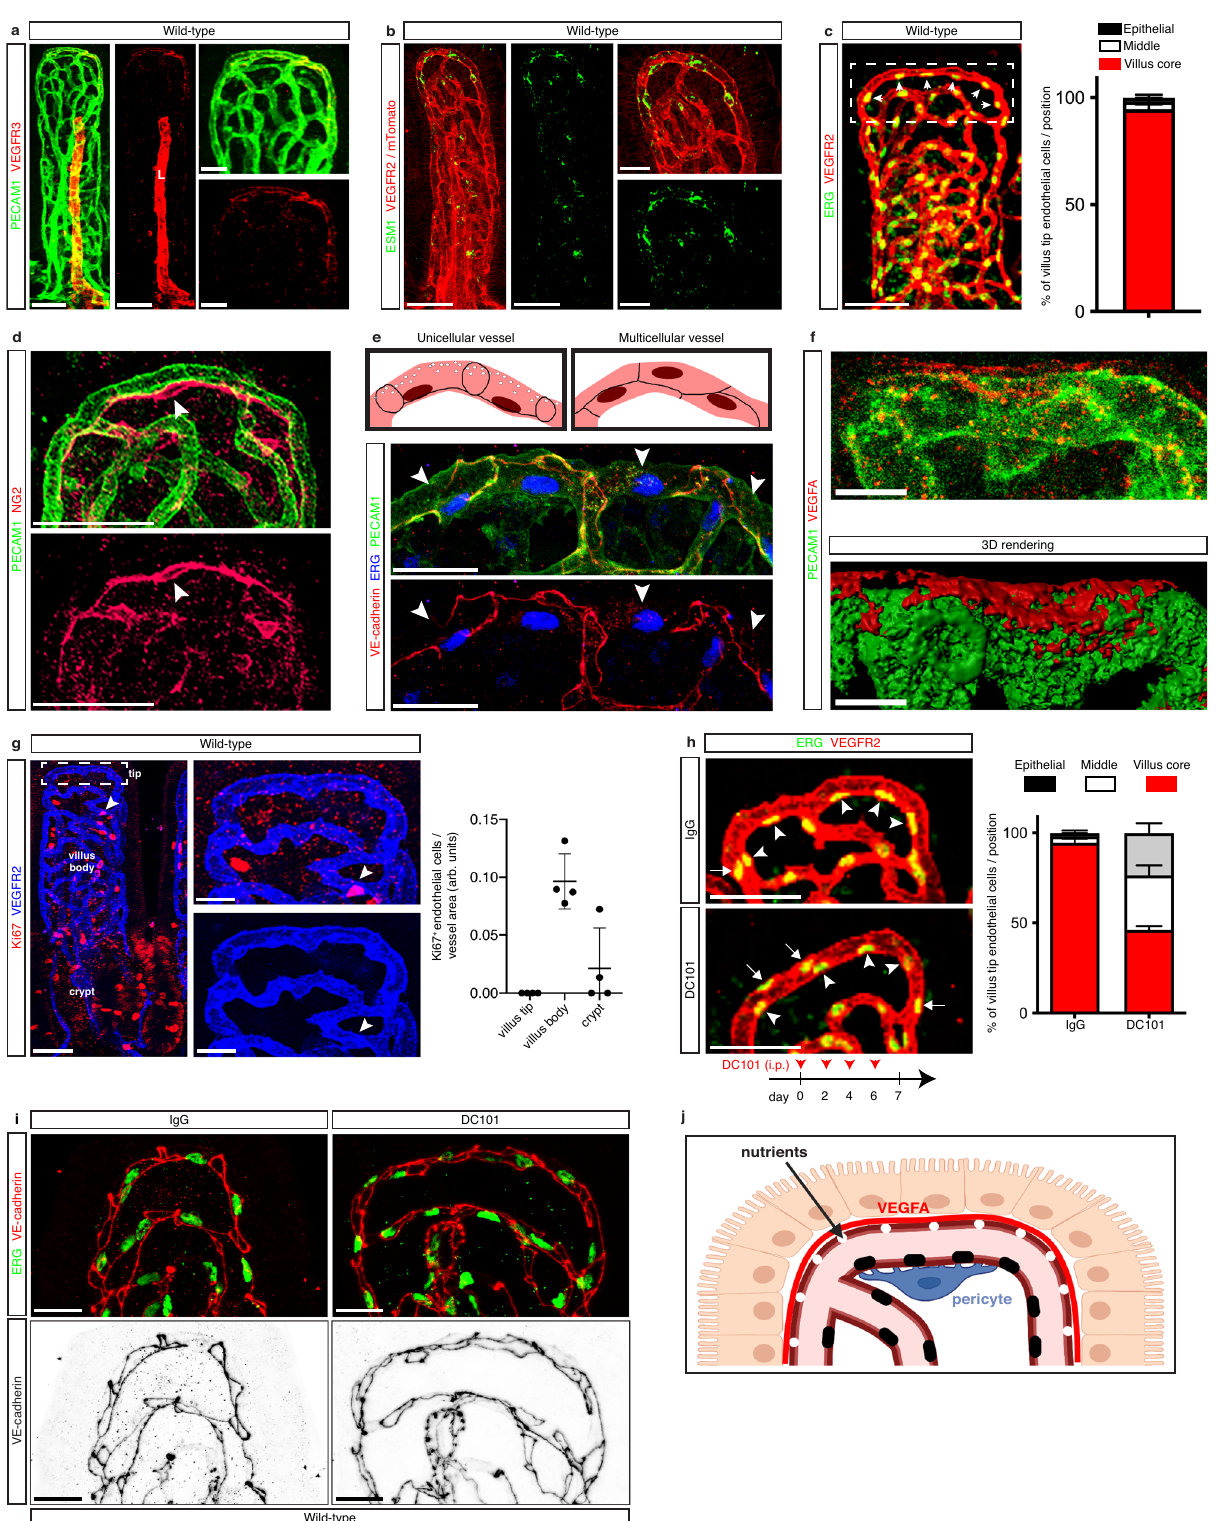
each zone. Highest numbers of Lgr5 + VTTs were observed in the duodenum and jejunum, while few VTTs were observed in the lower ileum (Fig. 2d, e). Of note, transgene expression in Lgr5- GFP-CreERT2 mice is mosaic with ~30% of crypts harboring GFP + cells, while 100% of ISCs express Lgr5 mRNA 29,30